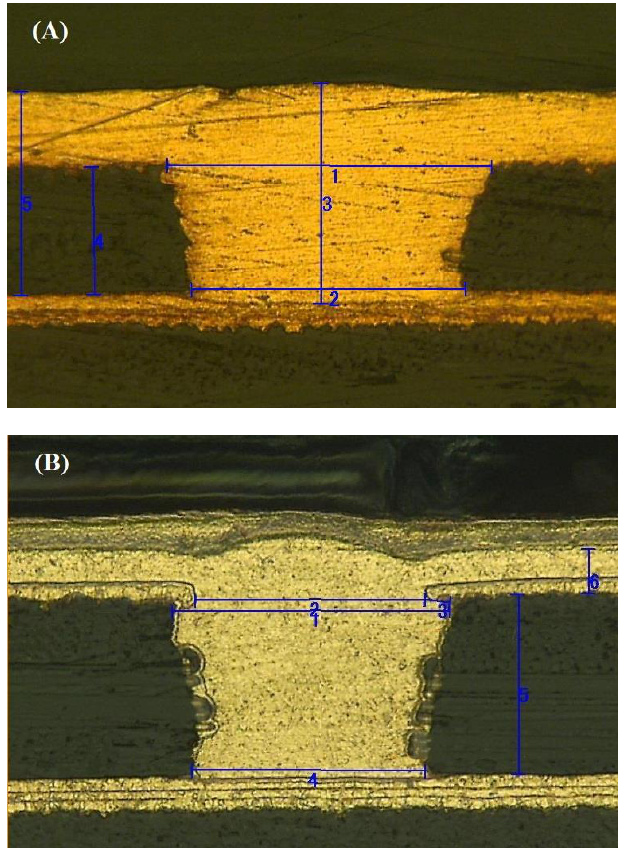
Figure 10. The representative section of metallographic micrographs of the blind holes. ( A ) A blind hole with a diameter of 100 µ m and a hole depth of 50 µ m, and ( B ) a blind hole with a diameter of 60 μ m and a hole depth of 70 μ m.